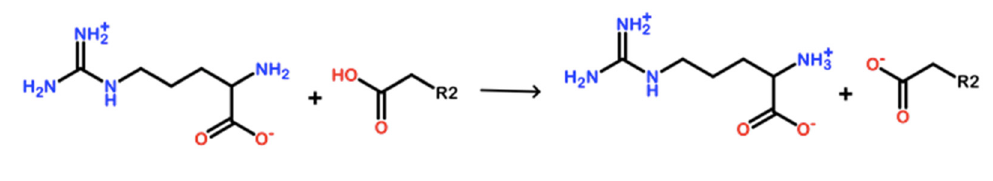
Figure 1. Chemical reaction of GS-2 components. An amine group on L-arginine reacts with the carboxylic acid group on capric acid to form an ammonium carboxylate salt.